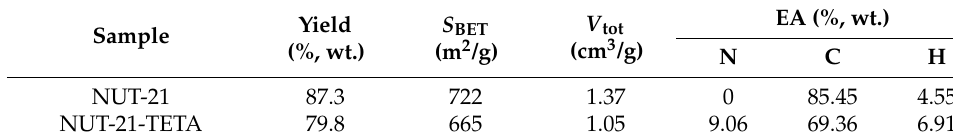
Table 1. Textural parameters and elemental analysis data of the resultant samples.